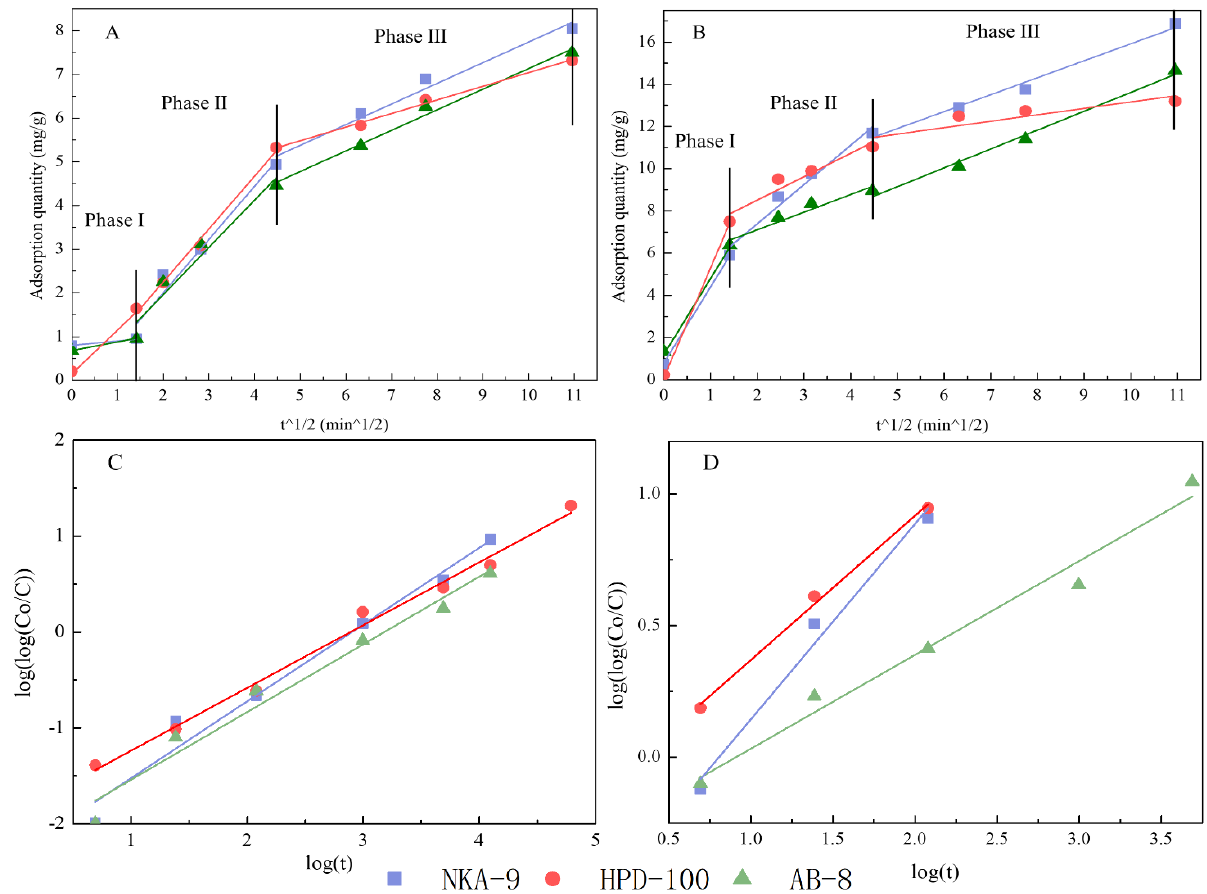
Figure 6. Weber-Morris intragranular diffusion kinetic model ( A , B ) and Bangham model ( C , D ) of polyphyllin II ( A , C ) and polyphyllin VII ( B , D ) on NKA-9, HPD-100, and AB-8. Table 4. The comparison of coefficient in different